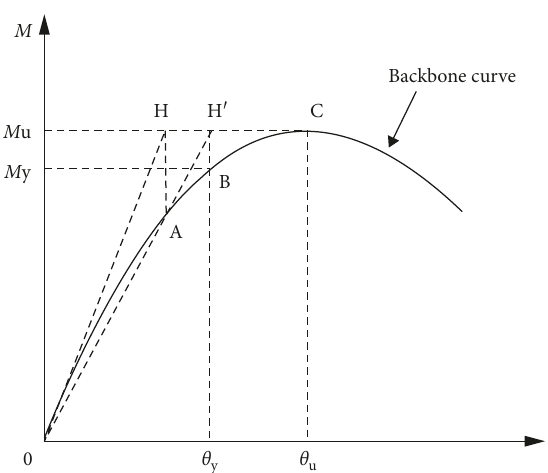
Figure 10: Stiffness deterioration calculation